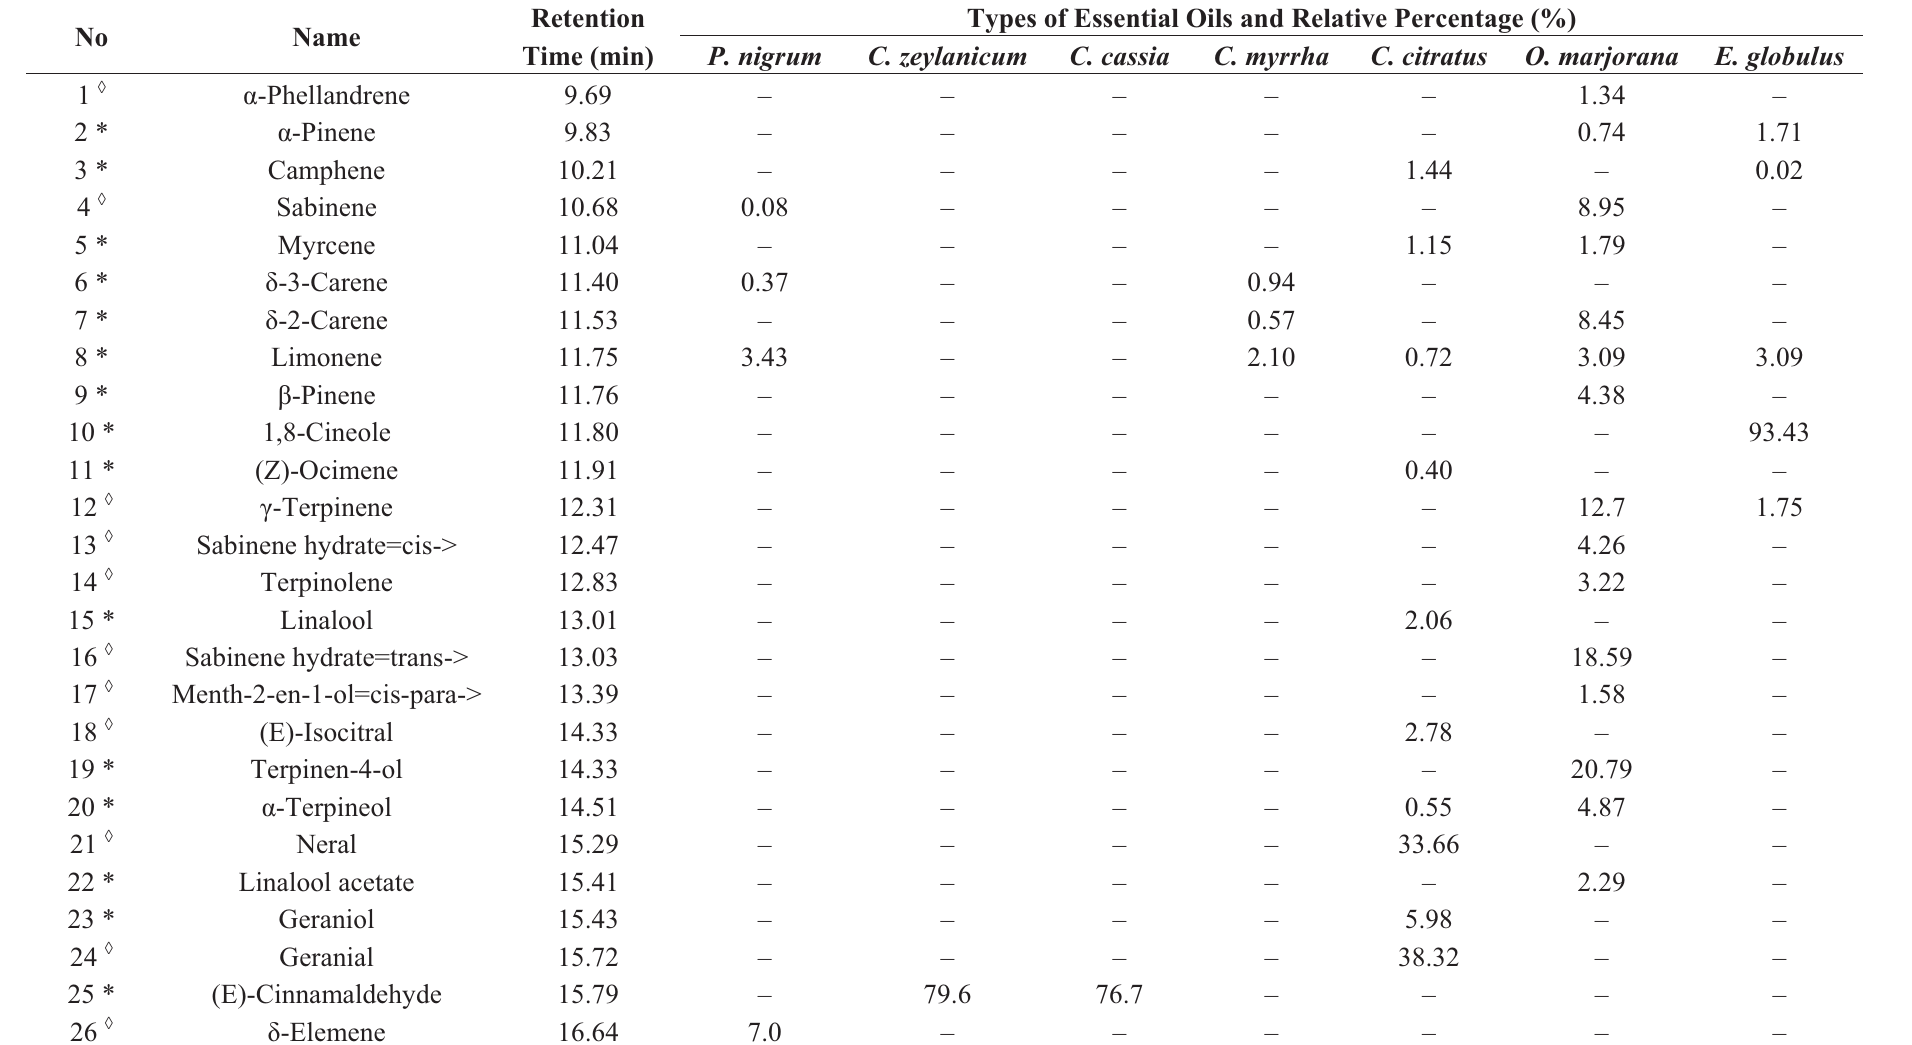
Table 3. Compounds of the top seven plant extracts identified using gas chromatography — mass spectrometry